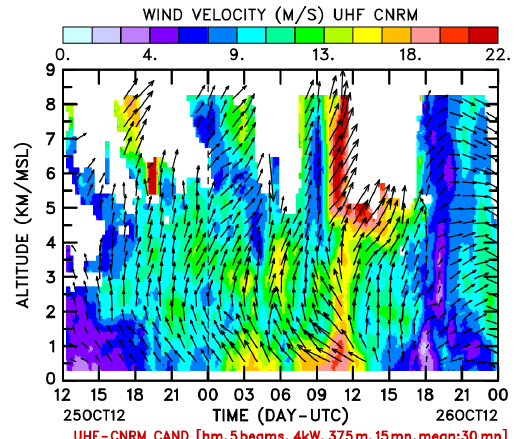
Figure 16. Time–height cross section of the wind measured by the Candillargues UHF radar for IOP16. Horizontal wind compo- nents are represented by the black arrows (meteorological conven- tion), and wind speeds are in colour. CNRM: Centre National de Recherches Météorologiques; CAND: